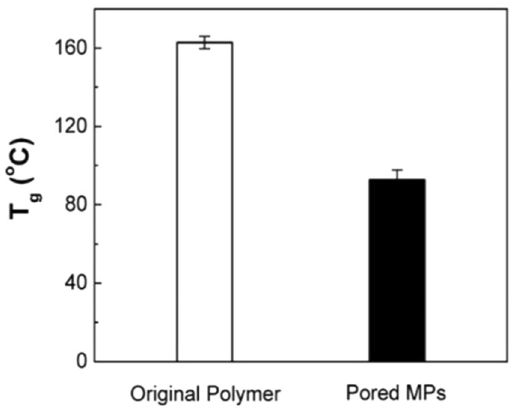
Figure 7. DSC analysis of original polymer and pored MPs ( n = 3, mean ±